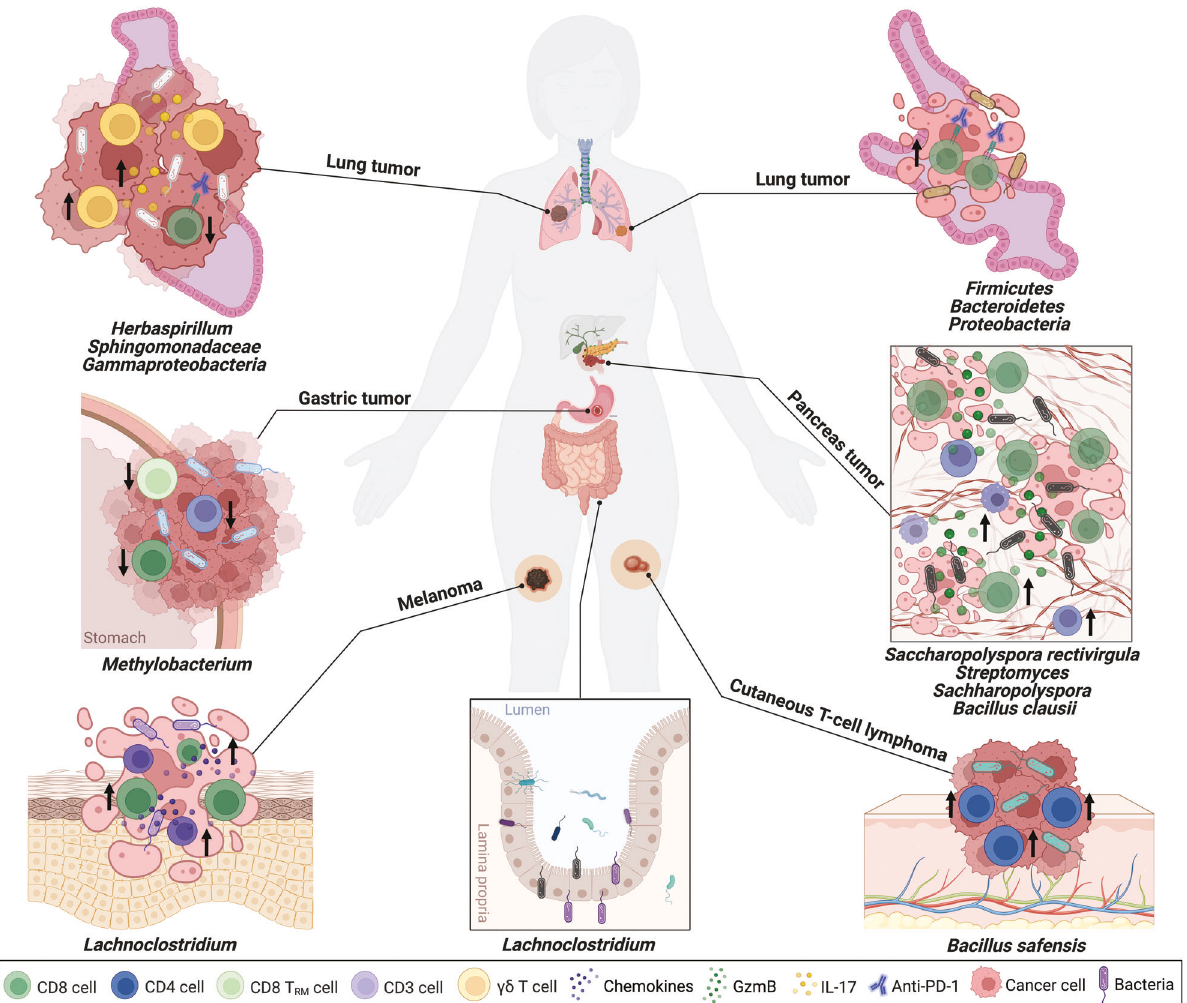
Fig. 2 The tumor microbiota may dynamically contribute to the microenvironment reconstruction and lead to cancer pathogenesis or tumor regression and eventually patient survival. Gut: Gut microbiota can exert an effect on tumor immunity both systemically and locally. Bacterial translocation from the gut lumen to the lymph nodes and blood can further shape the local tumor microbiome. Pancreatic cancer: Enrichment of Saccharopolyspora rectivirgula , Streptomyces , Sachharopolyspora , and Bacillus clausii can result in tumor in fi ltration and activation of CD8 + T cells and are associated with long-term survival and improved anti-tumor immunity in pancreatic cancer. Melanoma: Lachnoclostridium is correlated with in fi ltration of cytotoxic CD8 + T cells and high expression of chemokines CCL5, CXCL10, CXCL9 that collectively contribute to signi fi cant increase in patient survival in cutaneous melanoma. Gastric cancer: High abundance of Methylobacterium leads to low levels of CD3 + and CD8 + TILs, an exhausted CD8 + TRM phenotype and in fi ltration as well as decrease in TGF- β expression in the TME of patients suffering from gastric cancer, which collectively contribute to gastric cancer development. Lung cancer: High abundance of Gammaproteobacteria in the cancerous lung and their abundance in the tumor surroundings is signi fi cantly correlated with low PD-L1 expression that is also partly re fl ected in poor PFS and a trend toward worse overall survival under ICI therapy. While enrichment of Firmicutes , Bacteroidetes , and Proteobacteria in local NSCLC are associated with improved OS of ICI-treated patients. CTCL: Bacillus safensis , by inducing clonal proliferation of skin-homing T cells (such as CLA + , CCR4 + CD4 + T cells) leads to malignant T cell activation and increased STAT3 phosphorylation, which altogether result in tumorigenesis in CTCL patients. CCL5 C-C motif chemokine ligand 5, CXCL10 C-X-C